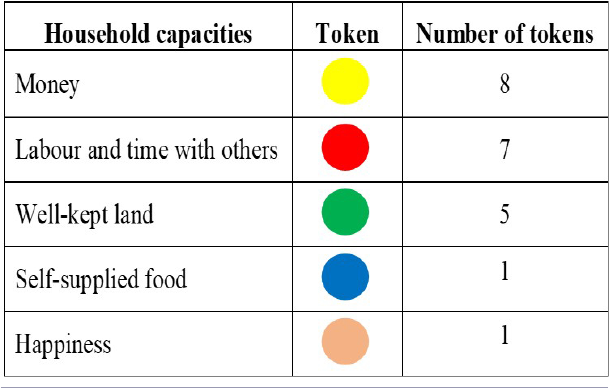
Fig. 4. The five capacities (and corresponding tokens) available to a household team at the start of the